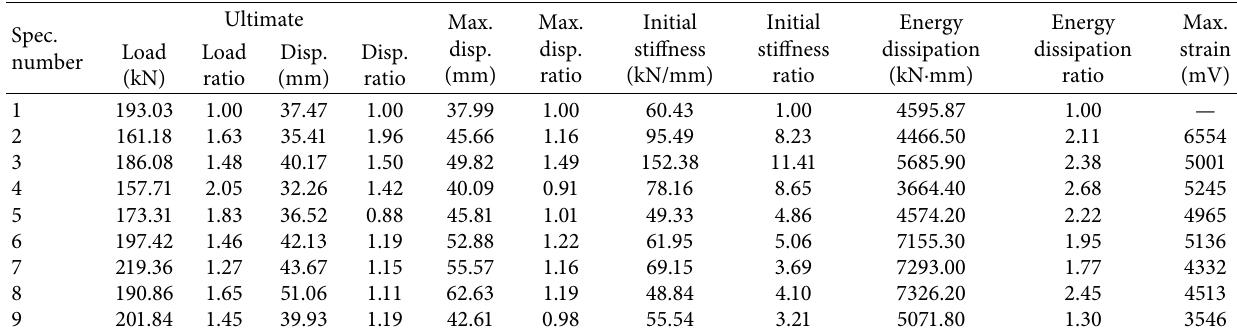
Table 3: Results of the experiment